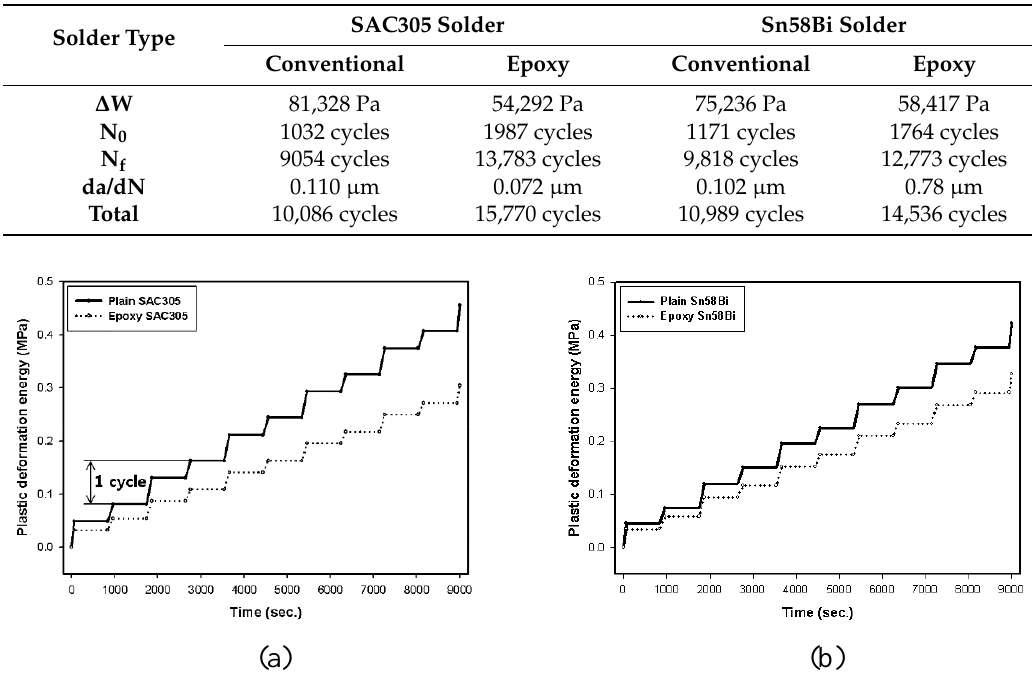
Figure 8. Accumulation of plastic deformation energy during testing: ( a ) SAC305 and ( b ) Sn58Bi solder joints.